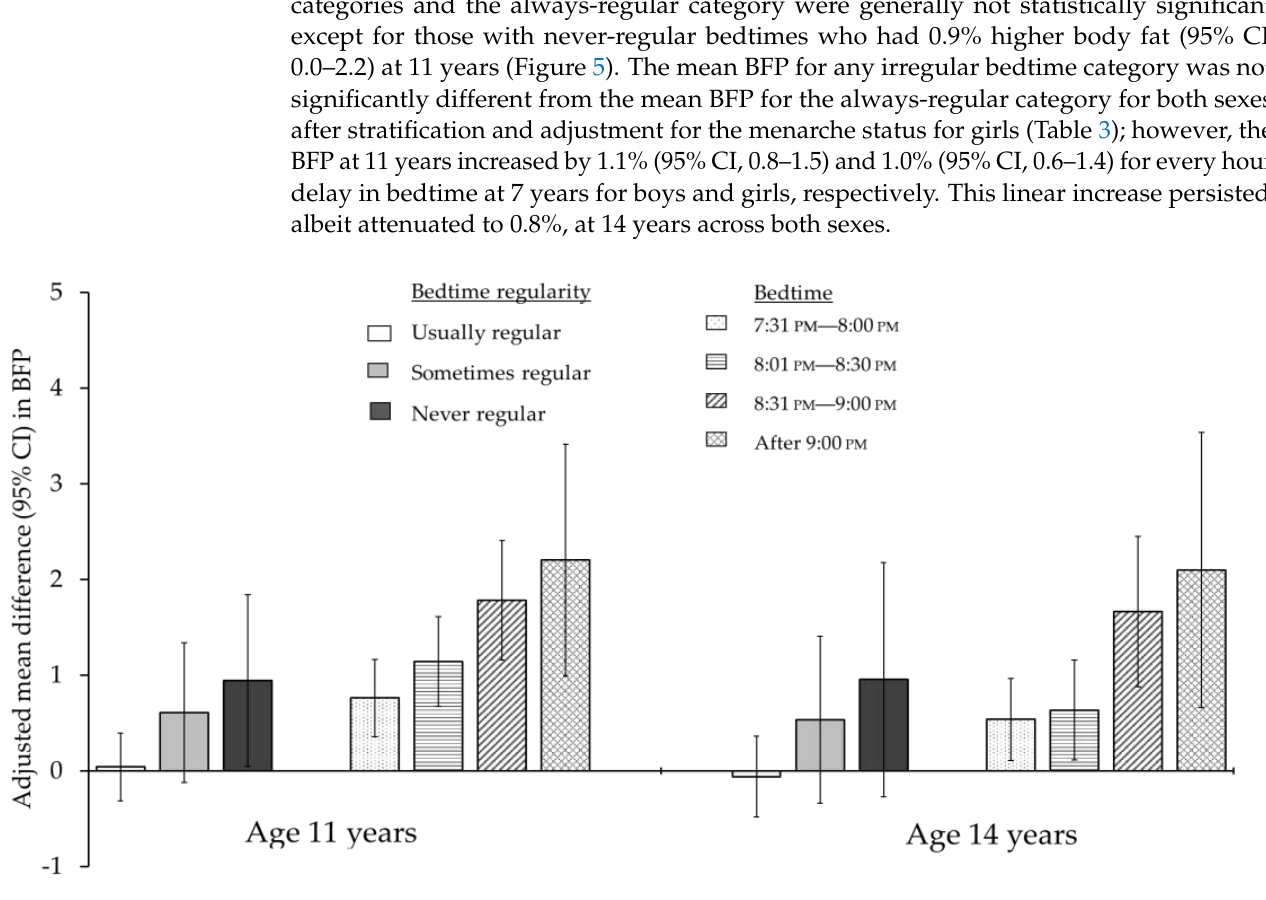
Figure 5. Adjusted mean difference in body fat percentage at 11 and 14 years by bedtime regularity and bedtimes at 7 years. Reference for bedtime regularity is always-regular. The reference category for bedtime is 7:30 PM or earlier. Models were adjusted for sex, age, ethnicity, parental SES, parental education, and number of persons in household.